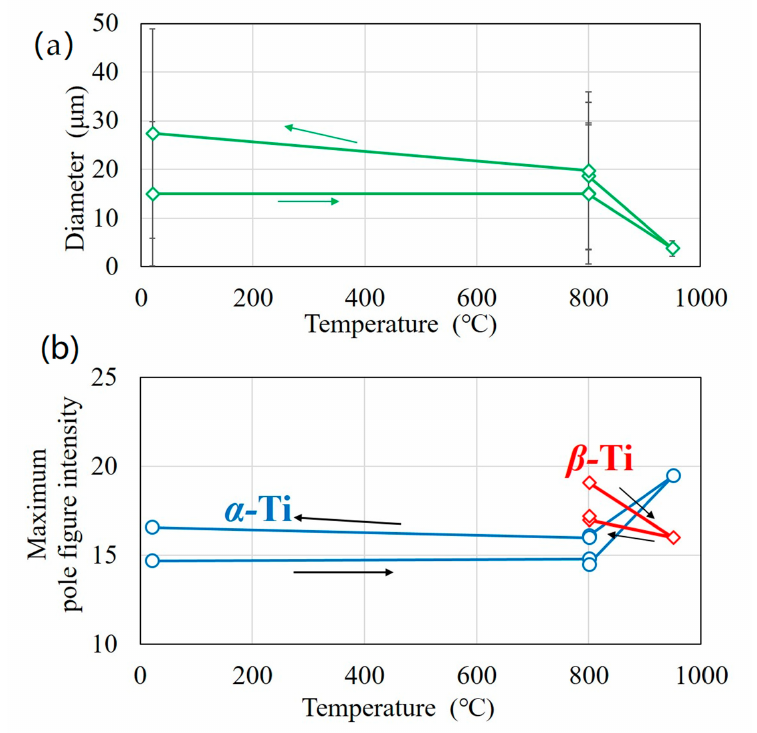
Figure 12. ( a ) Grain diameter and ( b ) {0002} pole density of α phase obtained by EBSD analysis. Figure 13 shows the grain map relationship of α phase between 950 ◦ C and 20 ◦ C analyzed in the same observation area. In the figures, the α phase grains at 20 ◦ C are recog- nized by grain boundaries as indicated by the black line, while grains are shown without boundaries at 950 ◦ C. The superimposed maps of Figure 13a,b are shown in Figure 13c,d. The figures are not perfectly superimposed with each other due to thermal